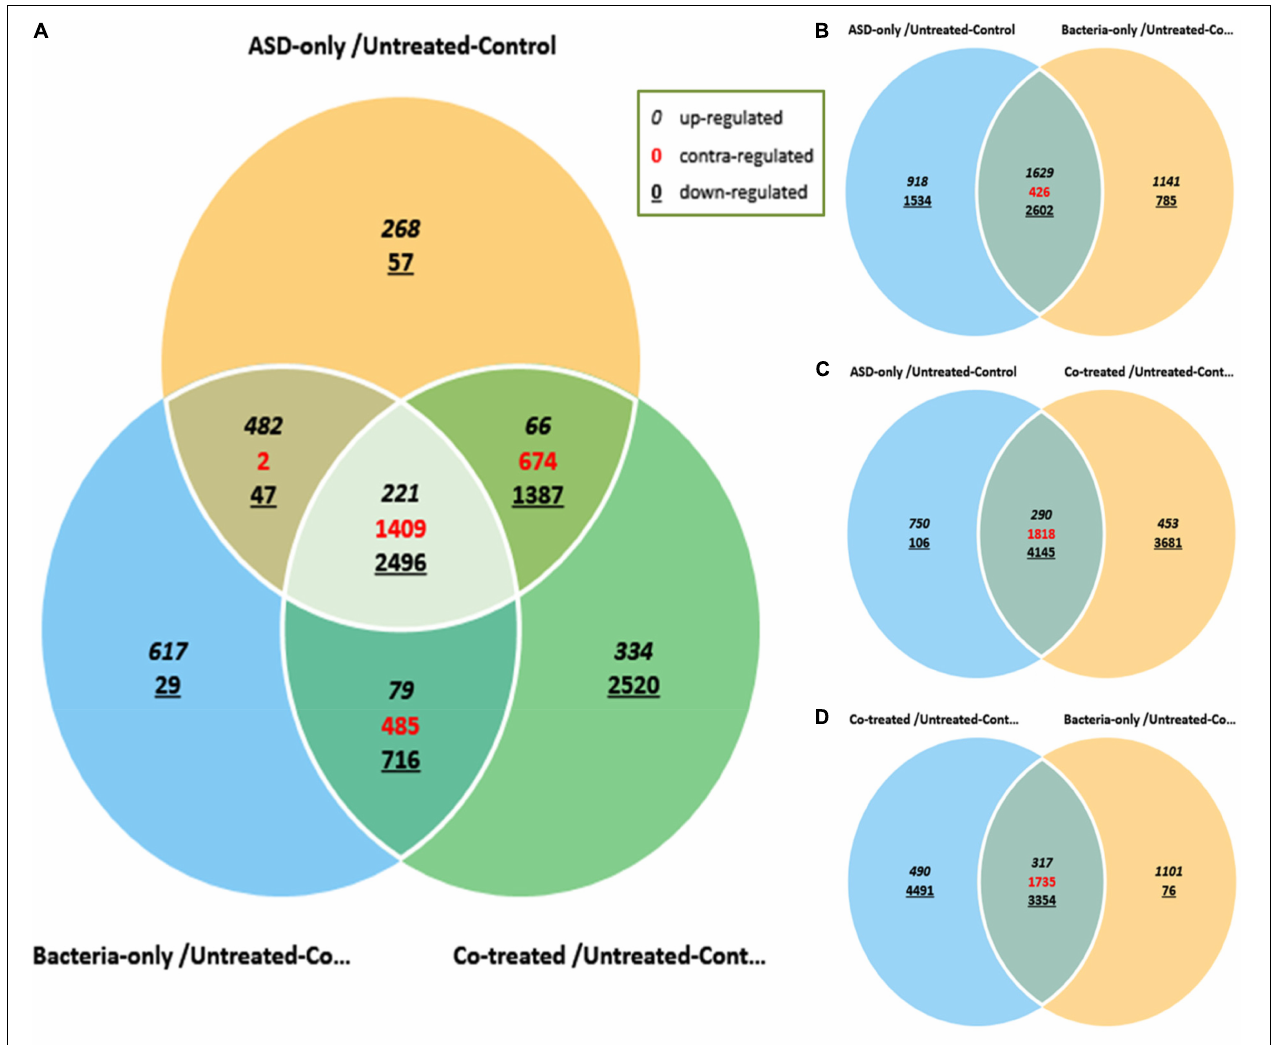
FIGURE 9 | Venn diagram showing differentially expressed genes of rat middle ear mucosa inoculated with ASD only or S. pneumoniae (bacteria) or co-treatment with respect to untreated. The global gene expressions were evaluated by Quant 3 (cid:48) m-RNA Sequencing. (A) Differentially expressed genes by ± 2-folds in all three treatments with respect to control. (B) Venn diagram showing differential gene expressions in ASD or S. pneumoniae treatment. (C) Venn diagram showing differential gene expressions in ASD or co-treatment. (D) Venn diagram showing differential gene expressions in S. pneumoniae or